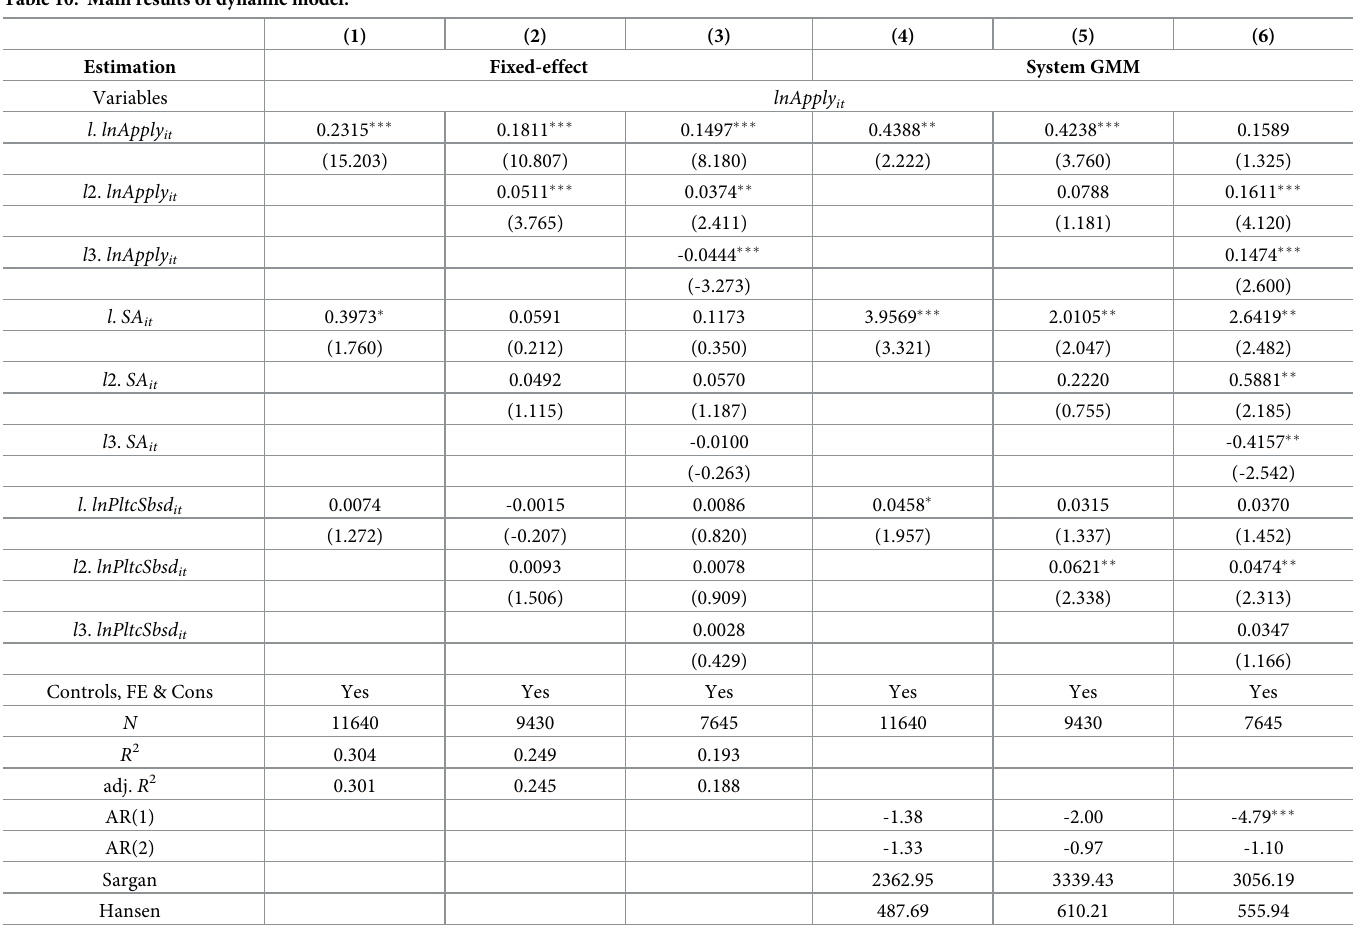
Table 10. Main results of dynamic model.